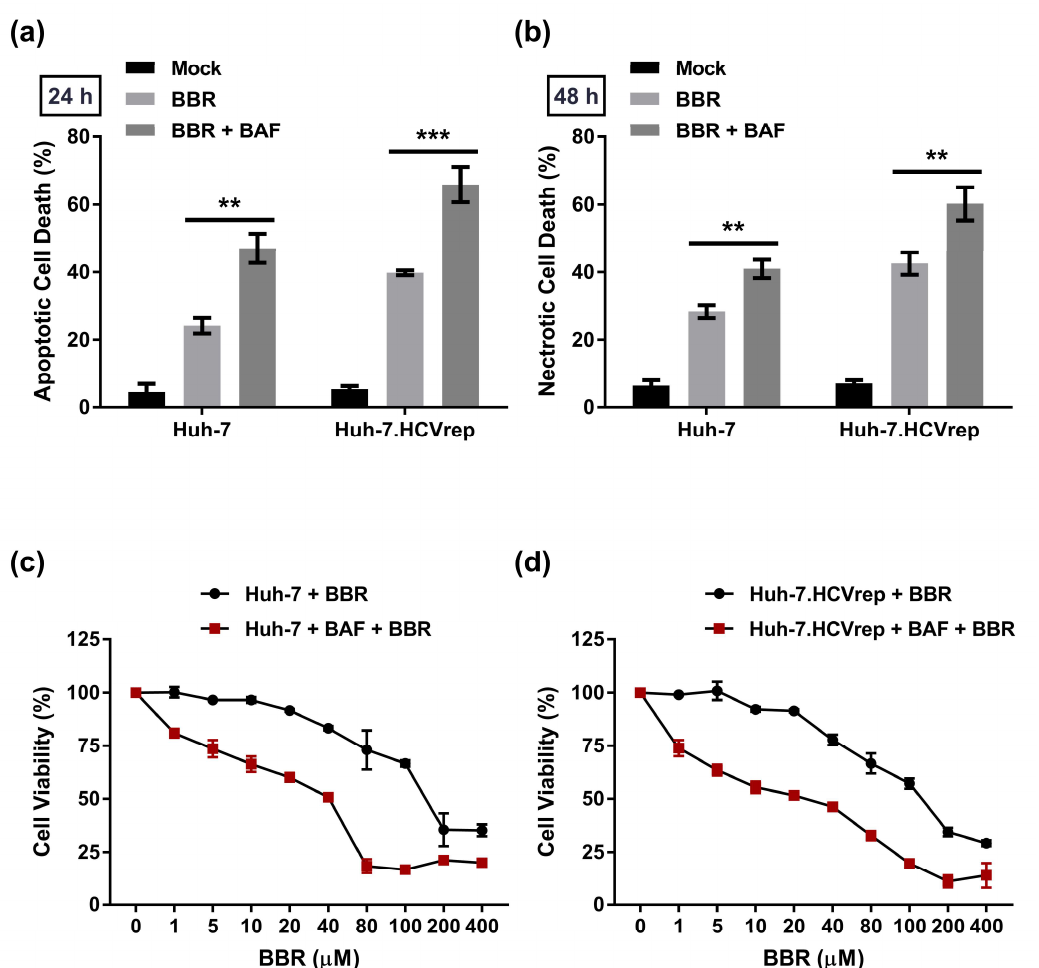
Figure 5. Bafilomycin A1 (BAF) pretreatment augmented BBR-induced cell death in the hepatoma cells. Figure 5 Huh-7 and Huh-7.HCVrep cells were seeded in six-well plates and pretreated with 100 nM BAF for 4 h. The cells were then treated with 100 µ M berberine (BBR) for ( a ) 24 or ( b ) 48 h before Annexin V / Propidium Iodide (PI) staining for flow cytometry analysis. ( c ) Huh-7 and ( d ) Huh-7.HCVrep cells were seeded in 96-well plates and pretreated with BAF, as above. The cells were subsequently treated with BBR at the indicated concentrations for 48 h before assessment using Cell Counting Kit-8 (CCK-8) cell viability analysis. The results are shown as means ± SD from 3 independent repeats for a and b, and two independent experiments for c and d. ** p < 0.01; *** p <